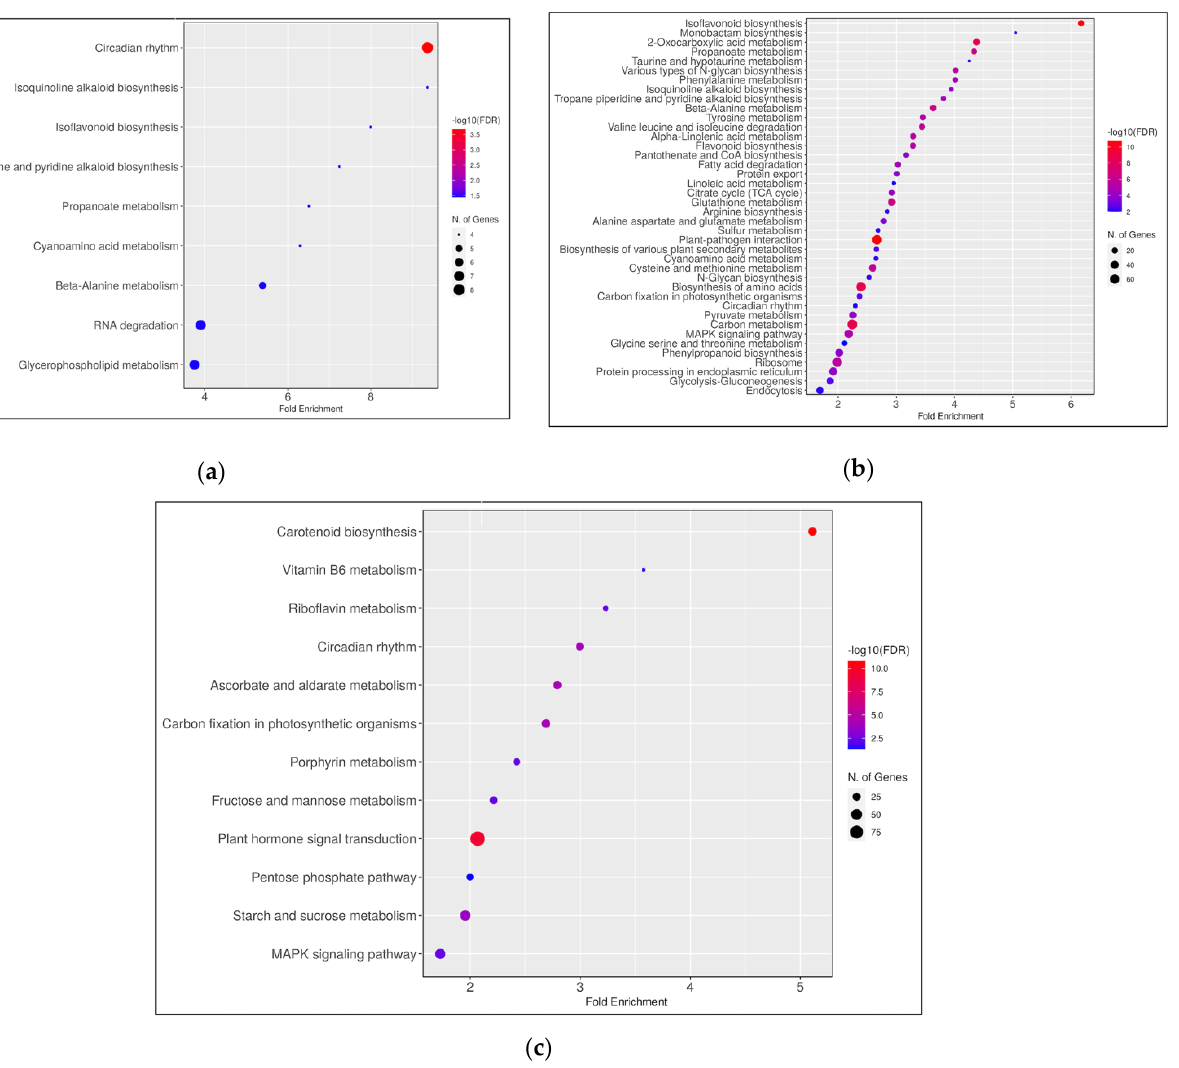
Figure 9. KEGG pathways and their Fold Enrichment at FDR < 0.05 using a list of the: ( a ) 100 ng/L group upregulated genes, ( b ) 1 mg/L group upregulated genes, and ( c ) the 1 mg/L group down- regulated genes. The analysis was carried using DEGs at p < 0.1 and log 2 -fold change > 1. The Fold Enrichment was calculated as the percentage of differentially expressed genes for each group belonging to a pathway, divided by the corresponding percentage of genes in the background. FDR is calculated based on nominal p -value from the hypergeometric test [29]. (Note: Only top 40 pathways of 56 are displayed for the 1 mg/L upregulated gene list. For the complete list see Supplemental S4). All of the upregulated pathways in the 100 ng/L group were also upregulated in the 1 mg/L group. We also found three pathways were both up-and downregulated in the 1 mg/L group i.e., Circadian Rhythm (FDR: up = 2.3, down = 3), Carbon Fixation (FDR: up = 2.4, down = 2.7), and MAPK signaling (FDR: up = 2.2, down = 1.7). Interestingly, the Circadian Rhythm pathway was the only differentially enriched intersecting pathway be- tween both groups. We noticed that 8 and 14 genes involved in the Circadian Rhythm pathway were, respectively, upregulated in the 100 ng/L and 1 mg/L groups (Supple- mental S1 — Table S3a,b and Supplemental S4 — Sheets 1 and 2) while 22 genes were down- regulated in the 1 mg/L group (Supplemental S1 — Table S3c and Supplemental S4 — Sheet